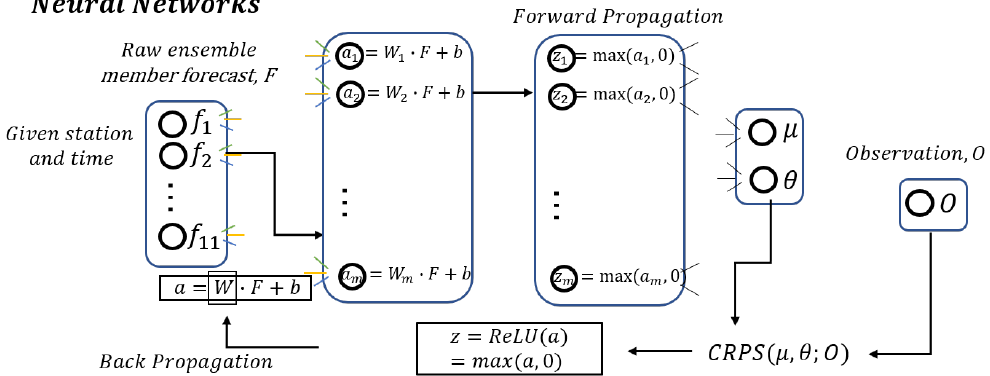
Figure 1. The flowchart of neural networks. 𝑭 or 𝑓 1 ,𝑓 2 ,…,𝑓 11 , the raw ensemble forecasts and as